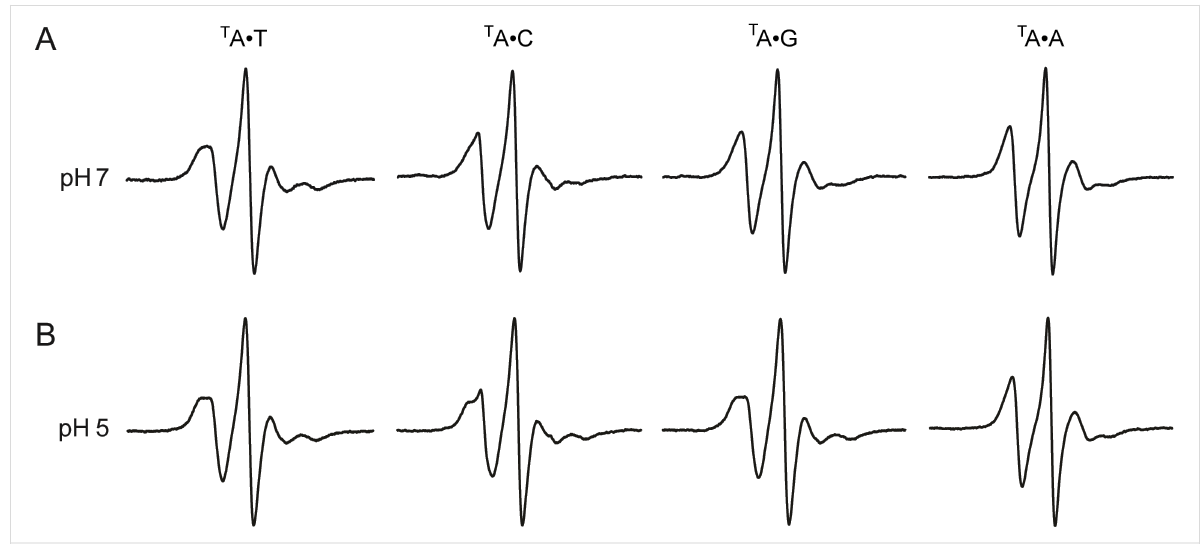
Figure 2: EPR spectra of 14-mer DNA duplexes 5 ′ -d(GACCTCG T AATCGTG)•5 ′ -d(CACGATYCGAGGTC), (10 mM phosphate, 100 mM NaCl, 0.1 mM Na 2 EDTA, pH 7.0 (A) and 5.0 (B)) at 10 °C, where T A is paired with either Y = T, C, G or